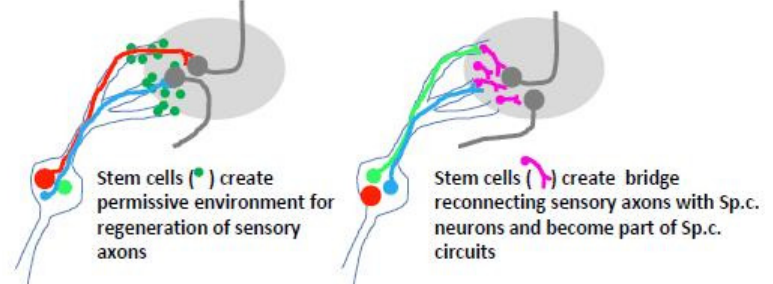
Figure 4. Two options based on the use of stem cell-based transplants at the DREZ, to facilitate entry of injured dorsal root axons (left) or to create a neuronal relay between dorsal root axons (forming synapses with the relay) and the host spinal cord circuitry (right).